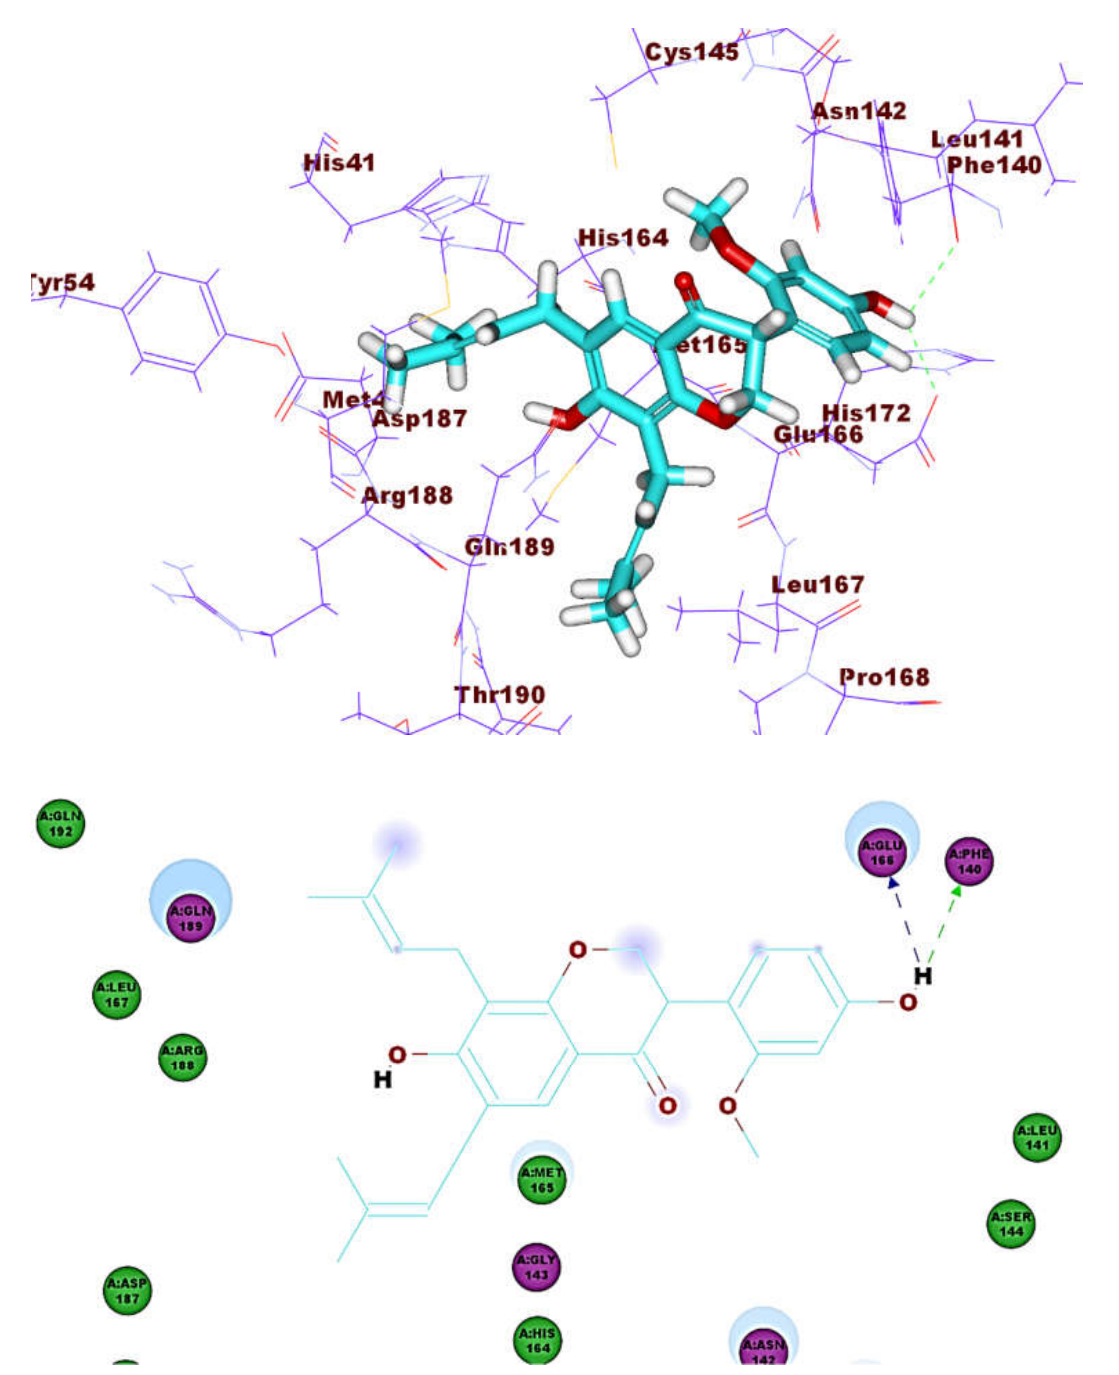
Figure 14. Compound 53 docked into M pro , forming two H. bonds with Glu166, Phe140.